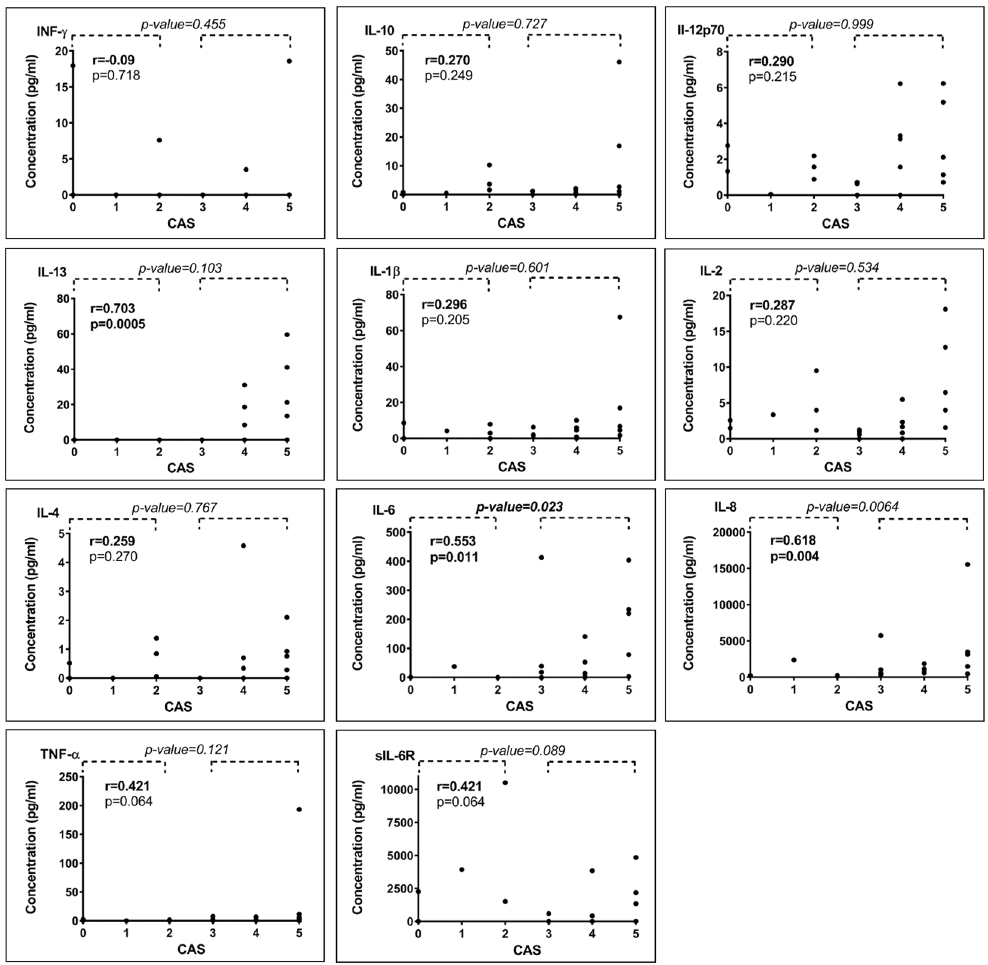
Figure 3. Cytokine concentration (pg/ml) in tears of TAO patients according to their CAS. P-values on the top of the figure relates to comparison between patients presenting CAS ≥ 3 and patients presenting CAS < 3. On the left of the figure, Spearman correlation (r) and its p-value are